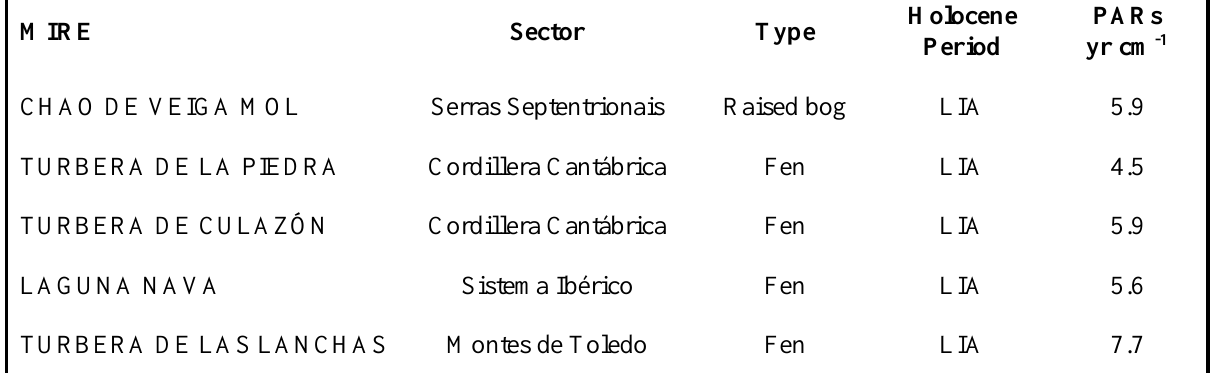
Table 3. Iberian peatlands with PARs of one centimetre in less than a decade. LIA = Little Ice